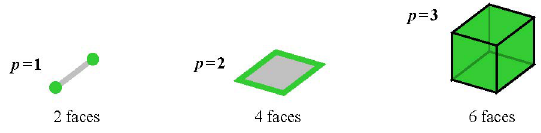
Figure 50: Faces of p -dimensional polytopes, for 1 ≤ p ≤ 3 .